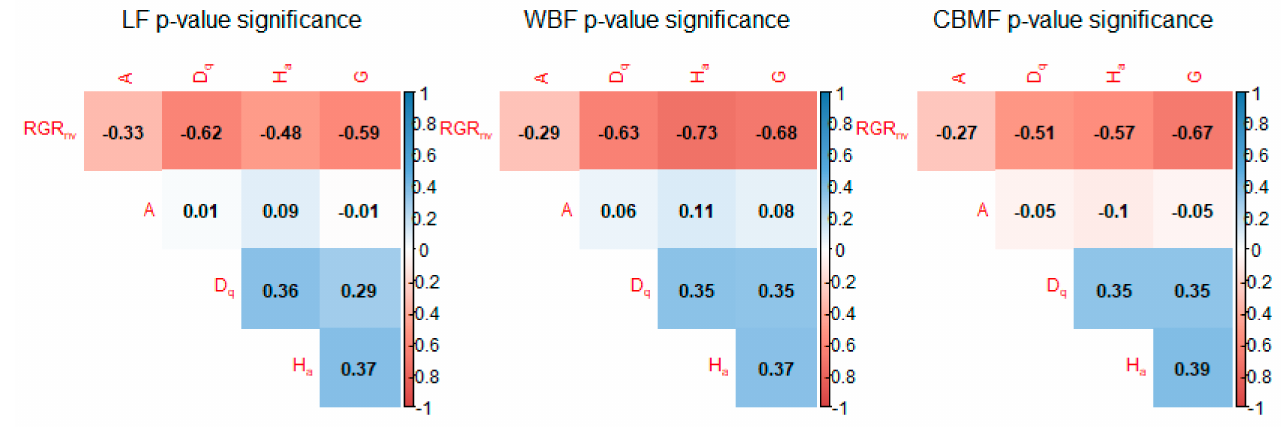
Figure 3. Standardized residual plots for the basic and mixed-effects models of the three forest types (( A ): LF, ( B ): WBF and ( C ): CBMF); BASIC-UN, BASIC-WE, MIXED-UN, and MIXED-WE represent the unweighted basic model, the weighted basic model, the unweighted mixed-effects model, and the weighted mixed-effects model, respectively.